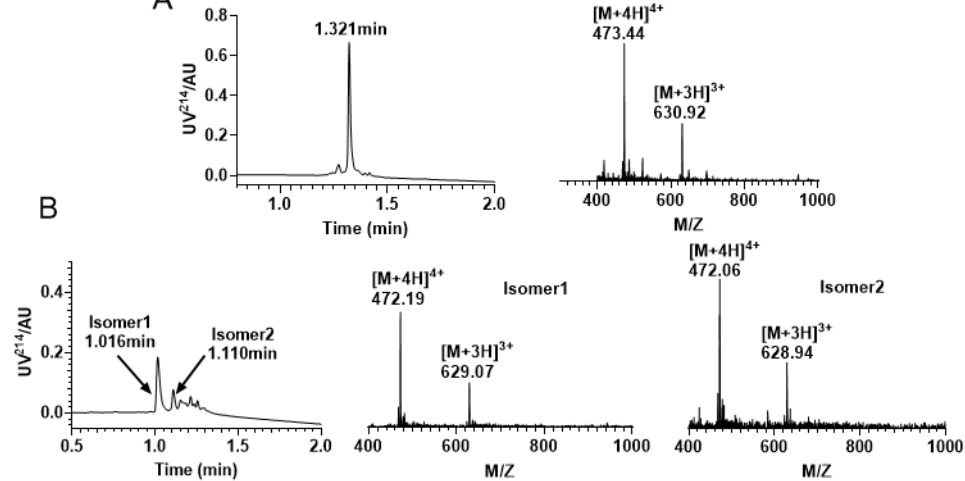
Figure 3. RP − UPLC and mass spectrometry traces of KIIIA by free random oxidation. ( A ) Linear RP − UPLC diagram of KIIIA with an observed mass of 1889.76 Da and a retention time of 1.321 min; ( B ) RP − UPLC diagram of the isomeric mixture produced by KIIIA, with an observed mass of isomer 1 1884.21 Da and a retention time of 1.016 min; The monitored mass of isomer 2 is 1883.82 Da and retention time is 1.110 min.